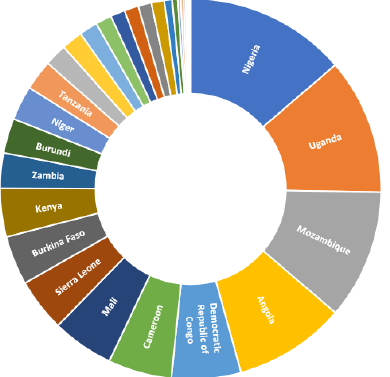
Figure 5. Distribution of additional malaria deaths per country in the 2020–2021 period.